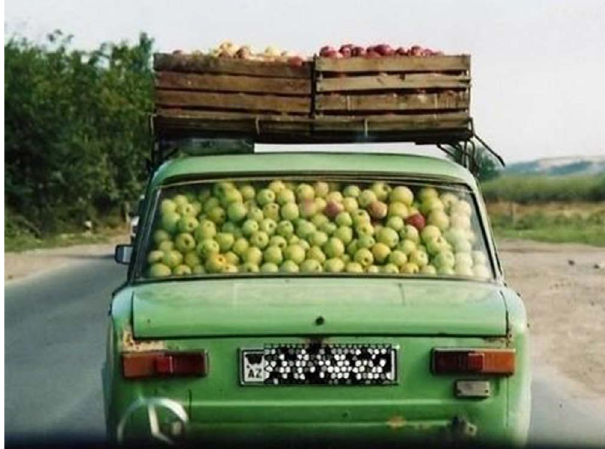
Figure 1. An apple found in a car is not synonymous of proof that apples grow in cars [18,